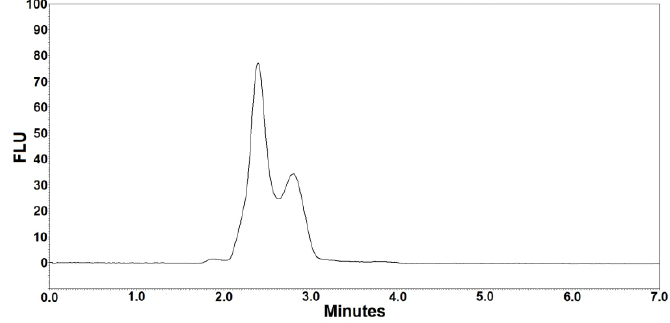
Figure 1. Blank chromatogram after extraction of analyte-free pooled human serum (blank sample).